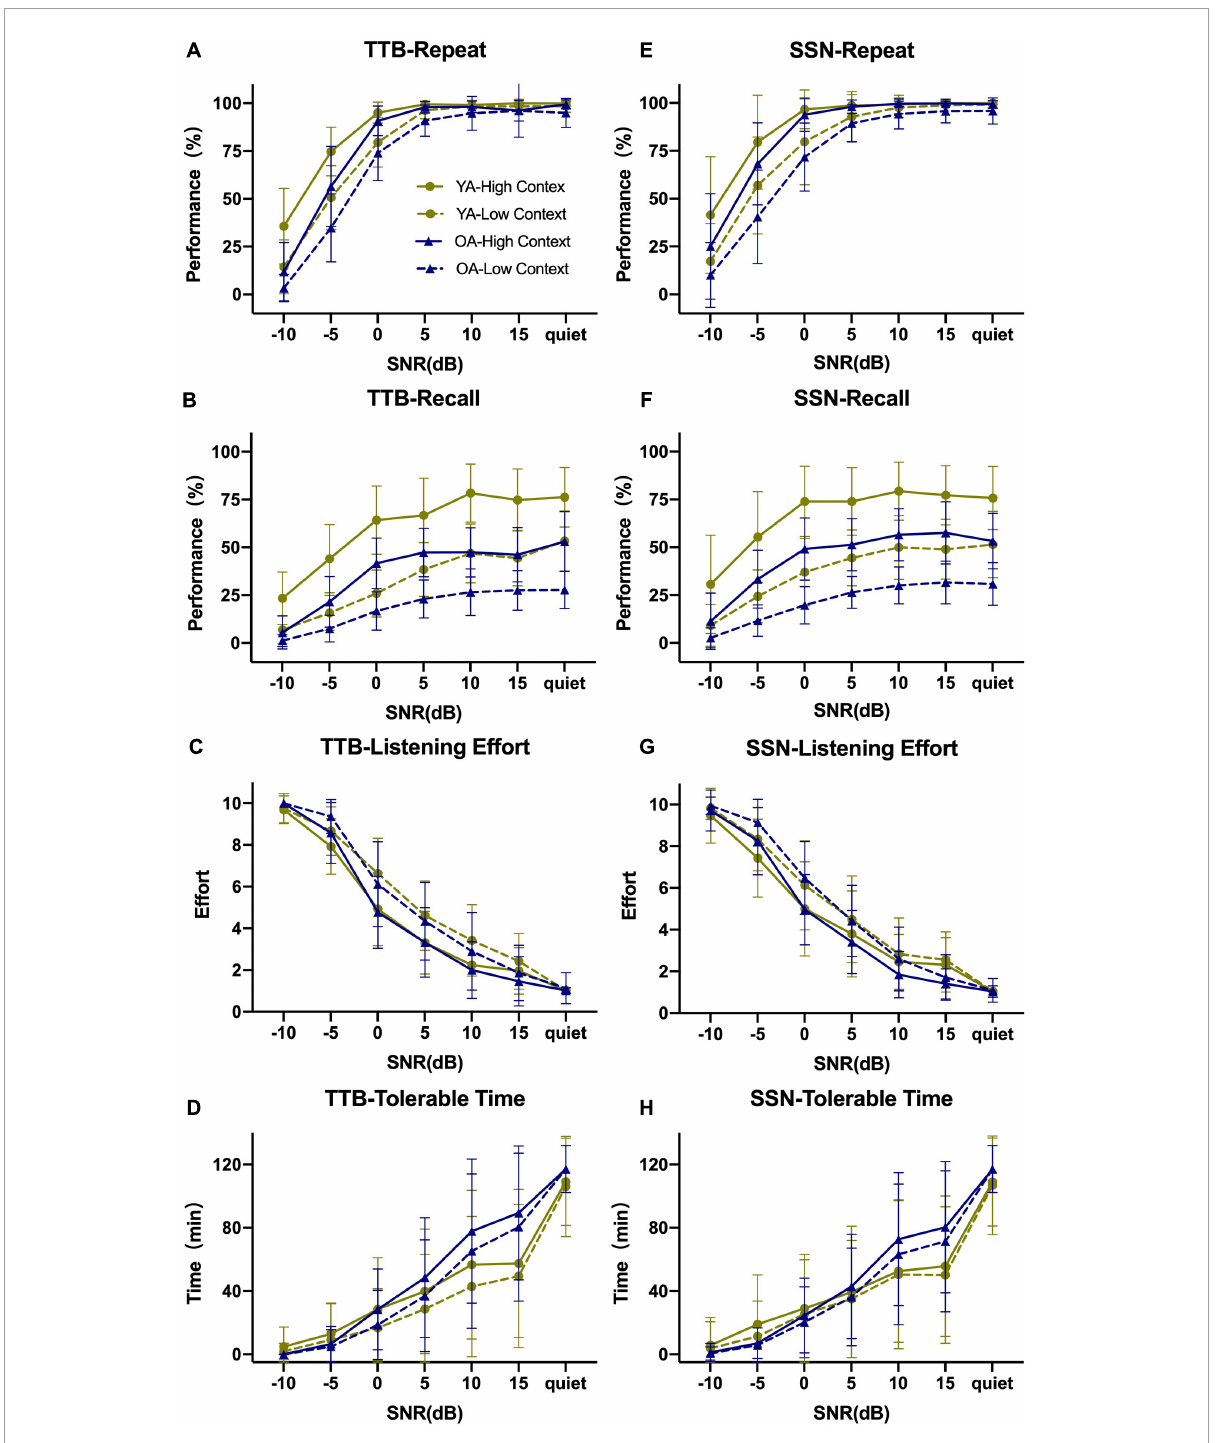
FIGURE1 Overview of Repeat–Recall Test (RRT) performance in two-talker babble (TTB) and speech-shaped noise (SSN) for both age groups in seven SNRs. (A–D) Performance for TTB; (E–H) performance for SSN. Both performances for Repeat and Recall would increase as SNR became high, along with decreasing LE and prolonging TT. Recall seemed more insensitive to SNR comparing with Repeat and the curves were more smoothy than Repeat. Error bars represented one standard